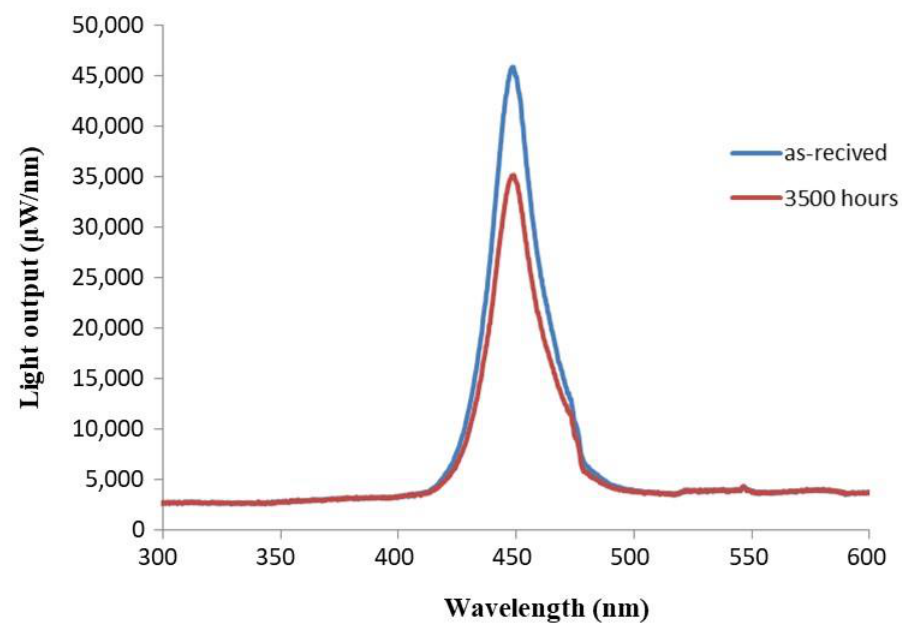
Figure 6. SPD of the saline water-exposed specimen at 100 °C for 3500 hours, compared to that of the as-received sample.